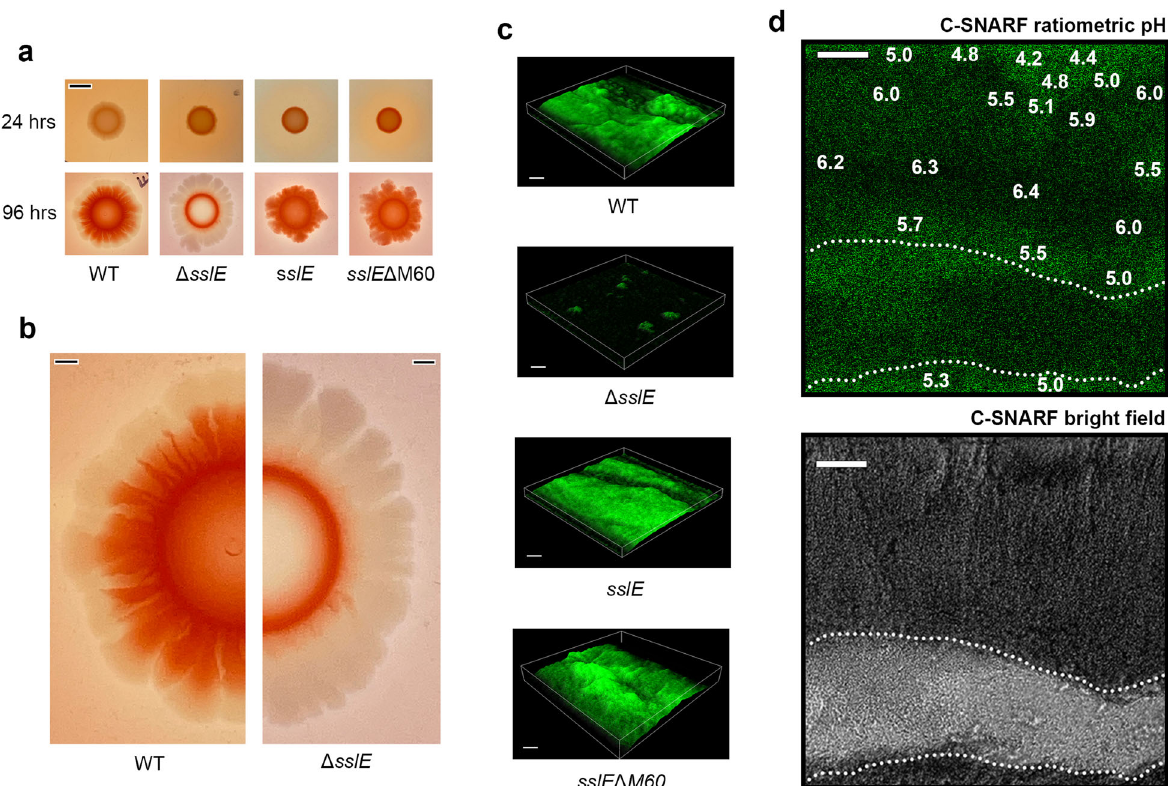
Fig. 5 Analysis of SslE-dependent bio fi lm formation by E. coli W strain. a Macrocolony bio fi lm phenotype of wild-type E. coli W and derivatives on LB Congo red agar medium after 24 and 96 h of growth. The derivatives sslE and sslE Δ M60 represent trans -complementation of intact sslE ( Δ sslE::sslE ) or sslE minus its M60 domain ( Δ sslE::sslE Δ M60), respectively, into the E. coli W Δ sslE mutant. Scale bar = 5 mm. b Zoomed- in image of the wild-type E. coli W and Δ sslE mutant. Scale bar = 2 mm. c CLSM images of wild-type E. coli W bio fi lms and E. coli W Δ sslE mutant and trans -complementation with sslE and sslE Δ M60 stained with FM 1-43 (green). Scale bar represents 20 μ m. d The pH across wild-type E. coli W bio fi lms grown for 96 h was monitored ratiometrically using C-SNARF-4 (green). pH values were calculated over ~30 μ m 2 boxes and pH values for representative regions within the bio fi lm fringes and centres are annotated. Dotted line outlines water channel within the bio fi lm, where pH values are not shown. Scale bar represents 20 μ m. All data are representative of at least three independent